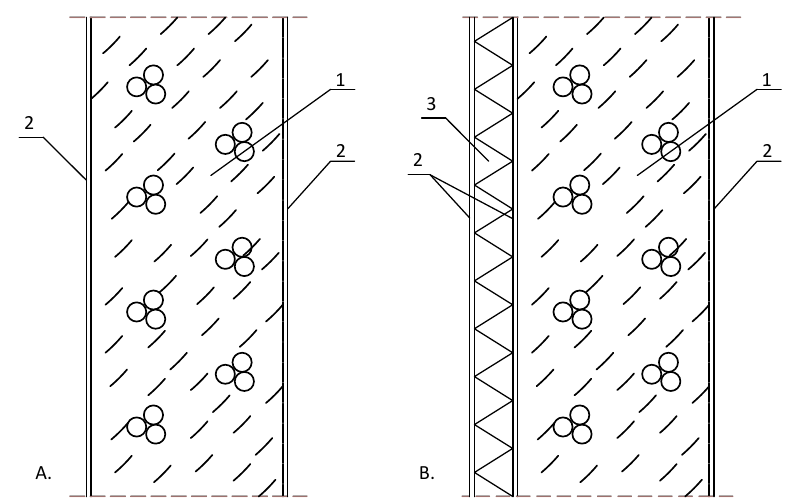
Energies 2020 , 13 , x FOR PEER REVIEW 6 of 14 Figure 2. Buildings external partitions (B1 and B2). ( A ) Before thermo-modernization. ( B ) After Figure 2. ( A ) Ground floor plan, ( B ) Attic floor plan. Source: Reference [32]. thermo-modernization. 1. Cellular concrete blocks; 2. Plaster; 3. Thermal insulation.